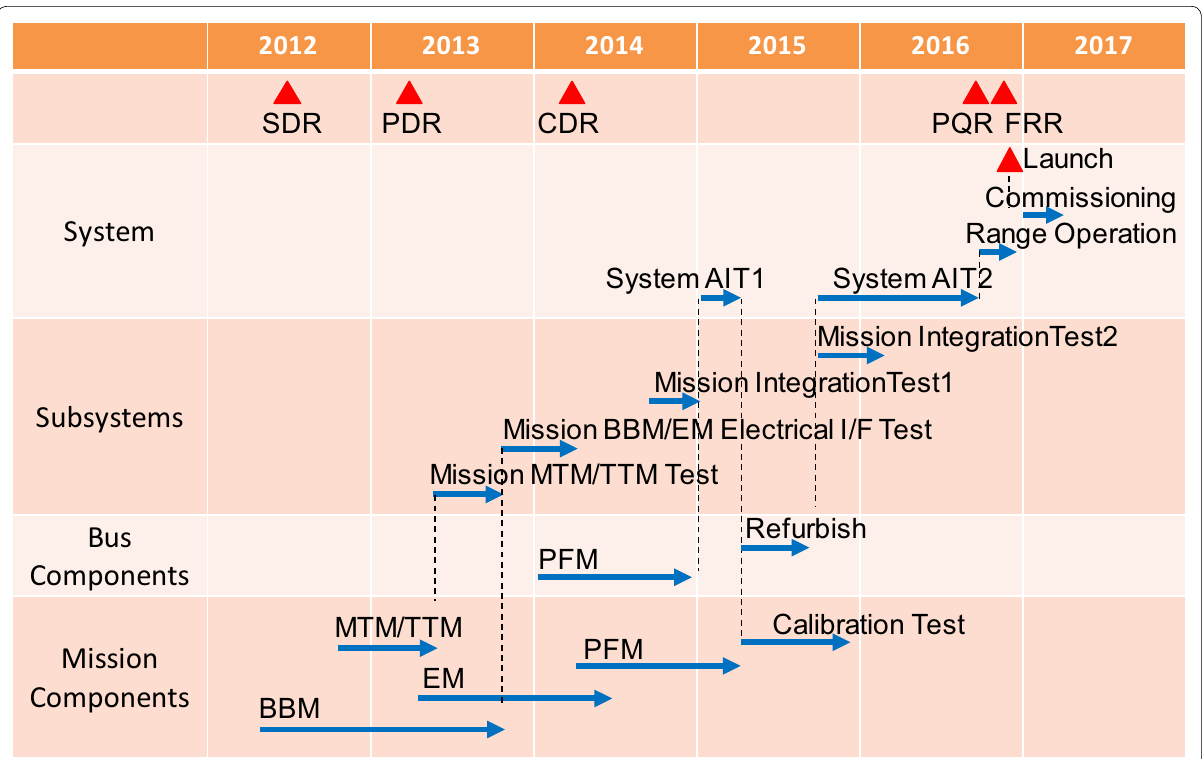
Fig. 11 Development schedule: In 2012, after the SDR, the ERG was selected as a formal JAXA project and the ERG project team was organized. The PDR took place in 2013 and the critical design review followed in 2014. The first system assembly, integration, and testing were conducted in early 2015 using flight models and engineering models. The final system test was conducted between October 2015 and September